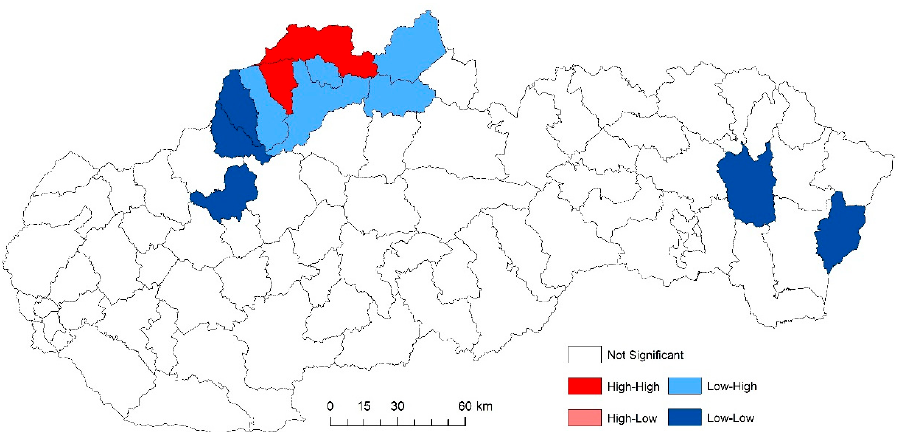
Figure 13. Standardized death rate of prostate cancer per 1000 inhabitants in European Standard Population, 2007–2012. Source: Statistical Office of the Slovak Republic, 2019.